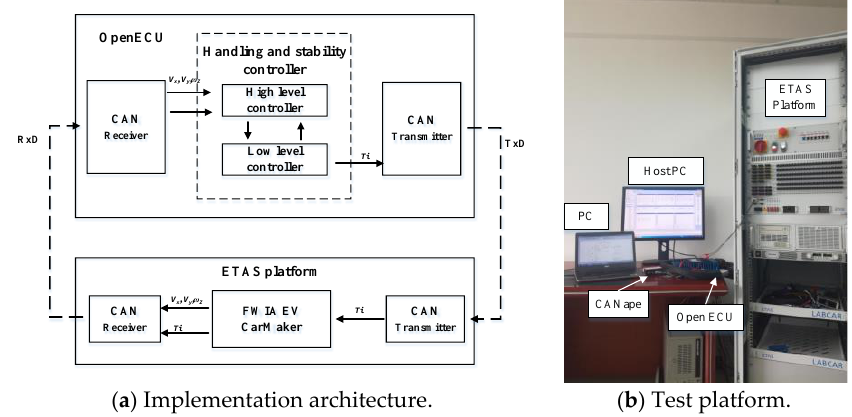
Figure 11. Hardware in the loop.